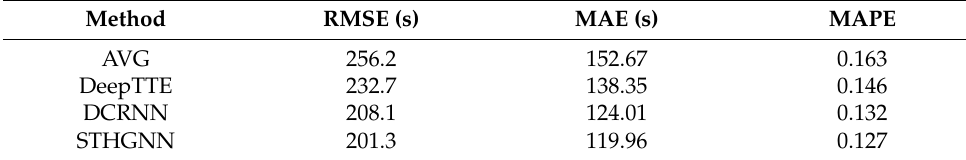
Table 3. Performance of STHGNN and